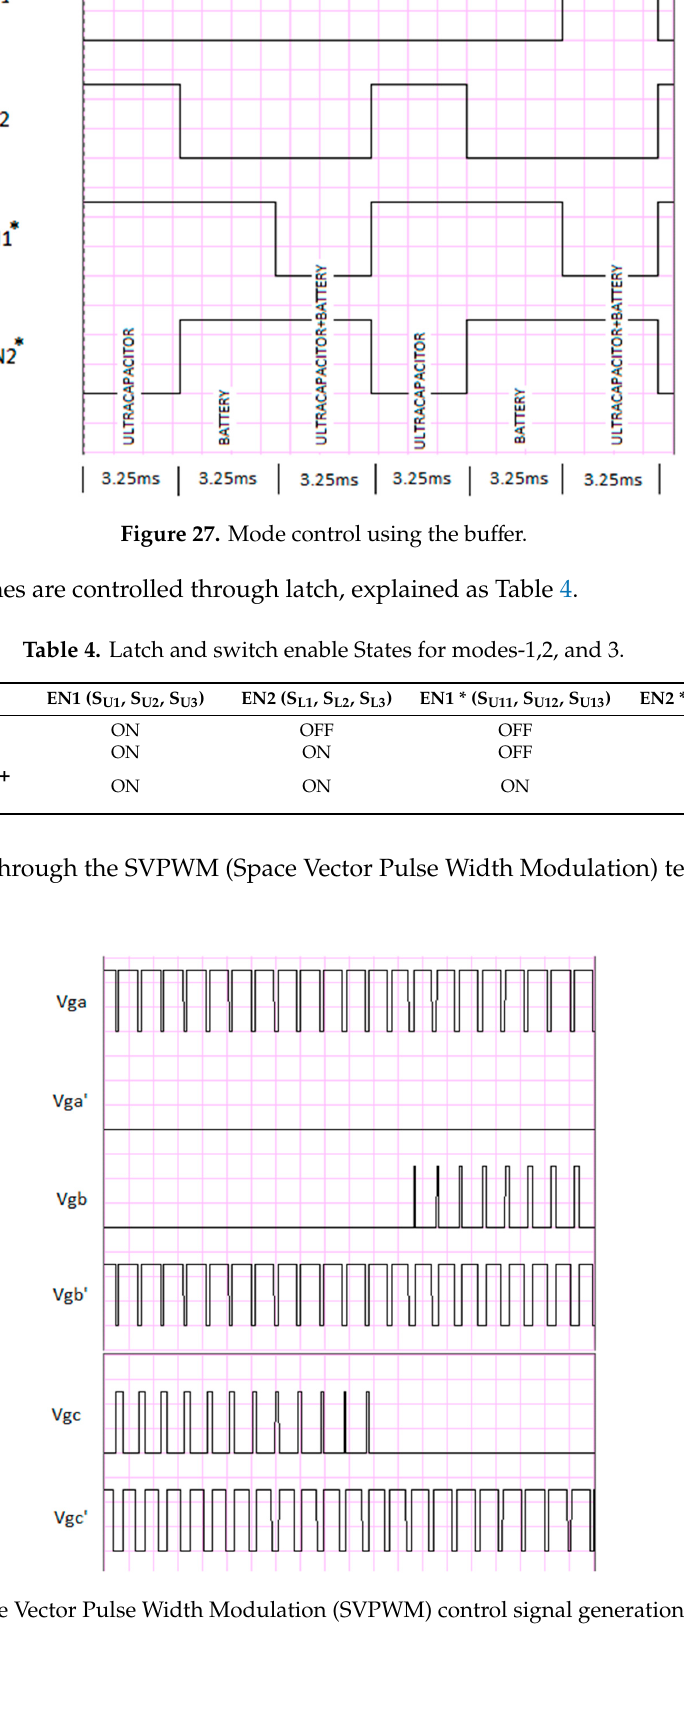
Figure 29. Process chart.